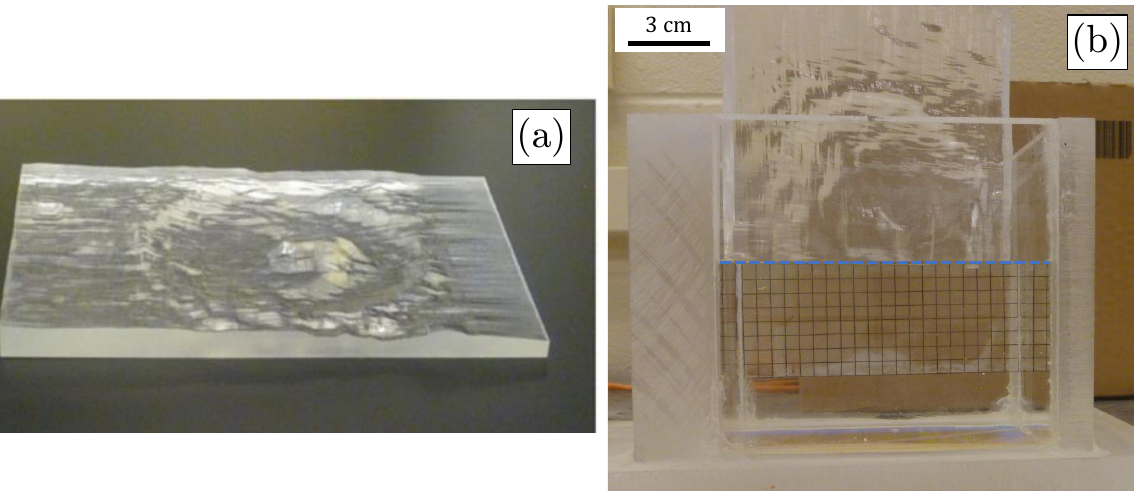
Figure 2. Photos of the realistic crater model ( a ) immersed in air and ( b ) partially immersed in an NaI solution. The dashed line in ( b ) demarcates the air–fluid